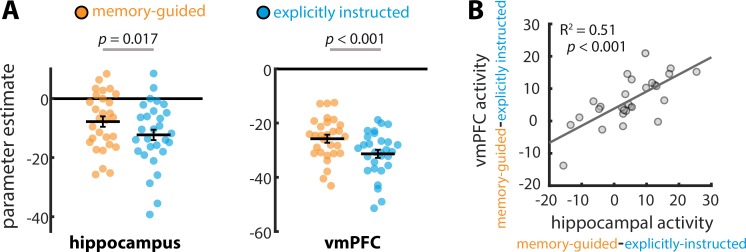
Univariate activity for memory-guided vs. explicitly instructed attention.(A) BOLD activity was higher for the memory-guided vs. explicitly instructed task, for both the hippocampus and vmPFC. Circles show parameter estimates (i.e., univariate BOLD activity) for individual participants. Solid lines show average parameter estimates across individuals, and error bars indicate standard error of the mean for the within-participant task difference (i.e., memory-guided – explicitly instructed). (B) The univariate activity enhancements for memory-guided attention (i.e., memory-guided parameter estimates – explicitly instructed parameter estimates) in the hippocampus and vmPFC were correlated across individuals.